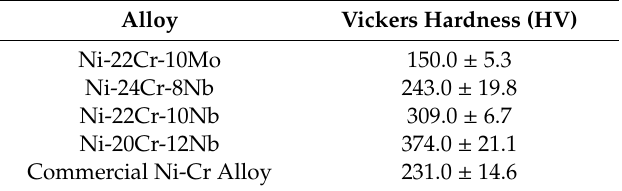
Table 4. Vickers hardness of the as-cast Ni-Cr-Mo and Ni-Cr-Nb alloys investigated in this work.